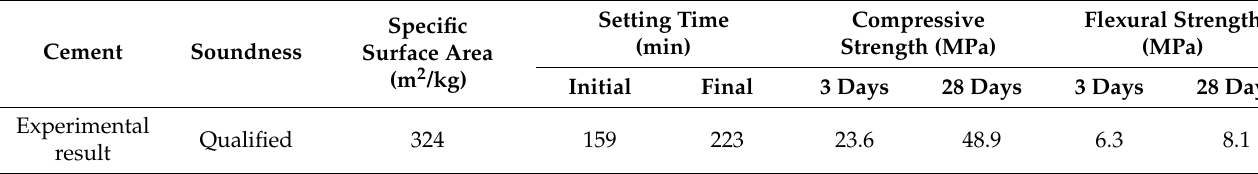
Table 1. Physical and mechanical properties of cement.